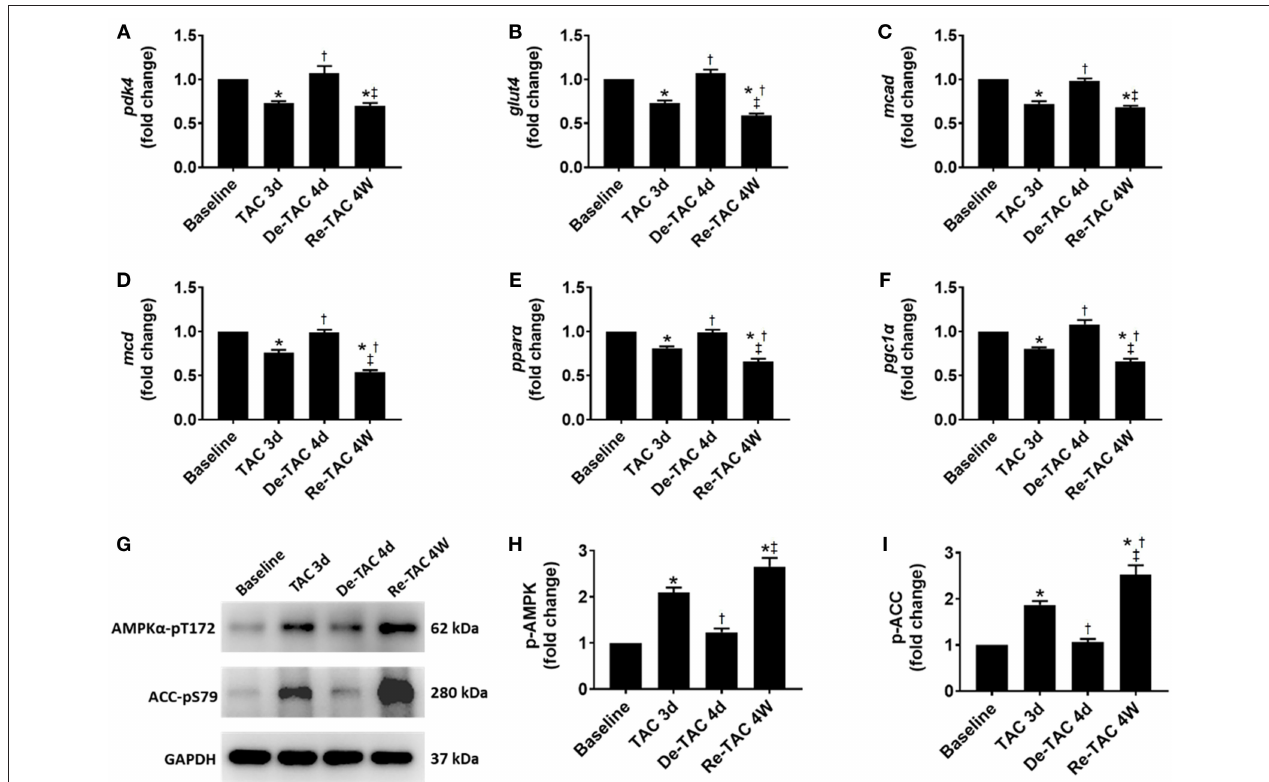
FIGURE 4 | Serial assessment of substrate utilization in HP murine hearts. Real-time quantitative PCR analyses for the gene expression of (A) pdk4 , (B) glut4 , (C) mcad, (D) mcd , (E) ppar α , and (F) pgc1 α . Representative images (G) and densitometric assessment (H,I) of cardiac p-AMPK and p-ACC as acquired by Western blot analysis. * P < 0.05 vs. Baseline; † P < 0.05 vs. TAC 3d; ‡ P < 0.05 vs. De-TAC